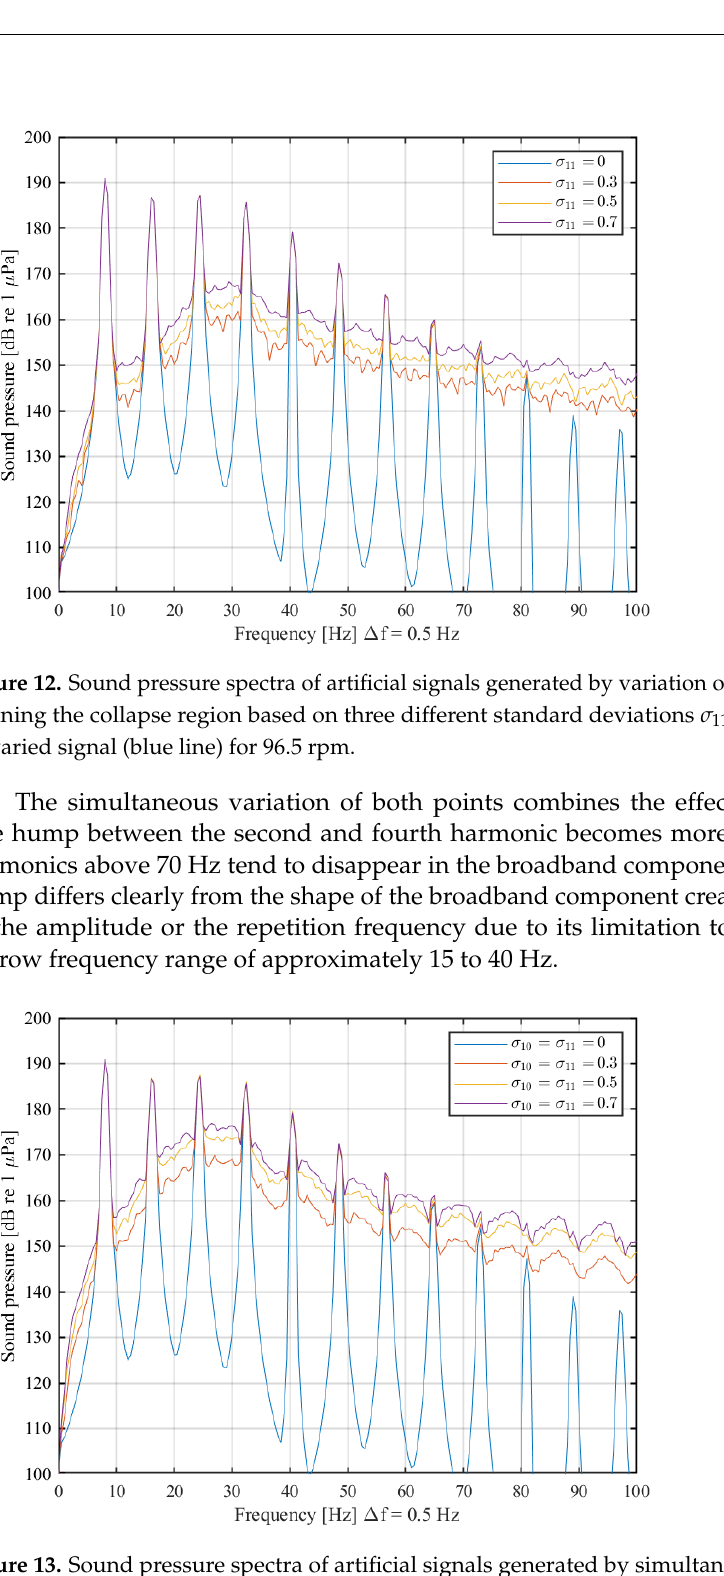
Figure 13. Sound pressure spectra of artificial signals generated by simultaneous variation of both control points defining the collapse region based on three different standard deviations σ 10 and σ 11 in comparison to the unvaried signal (blue line) for 96.5